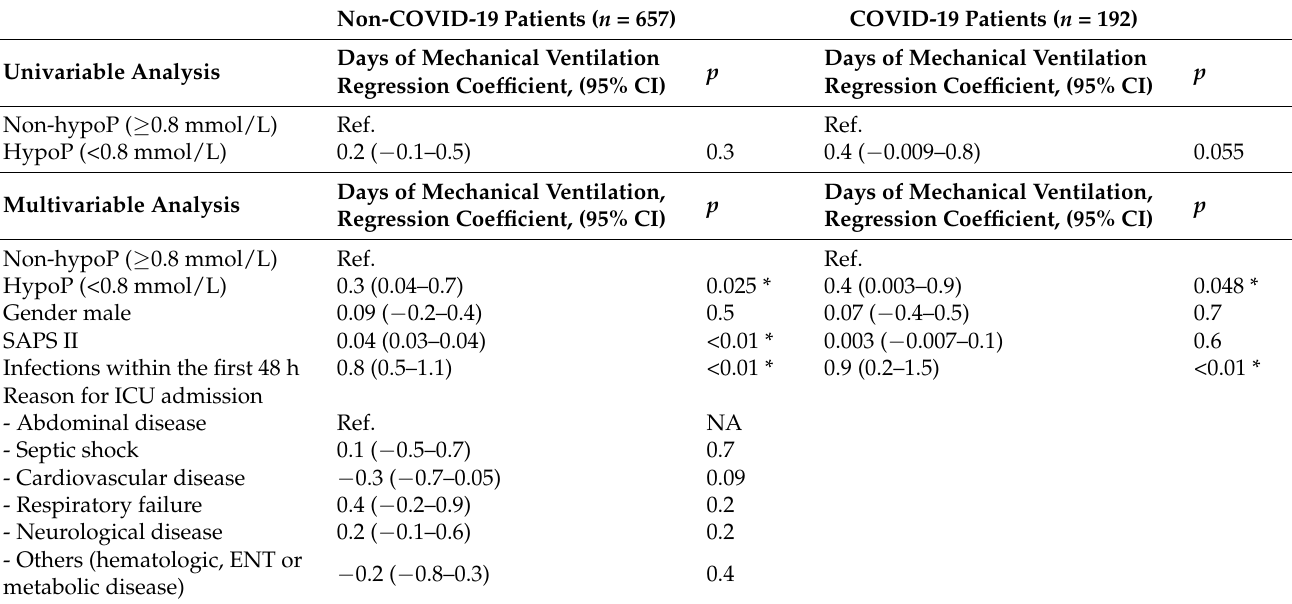
Table A3. Duration of mechanical ventilation in non-COVID-19 and COVID-19 patients.